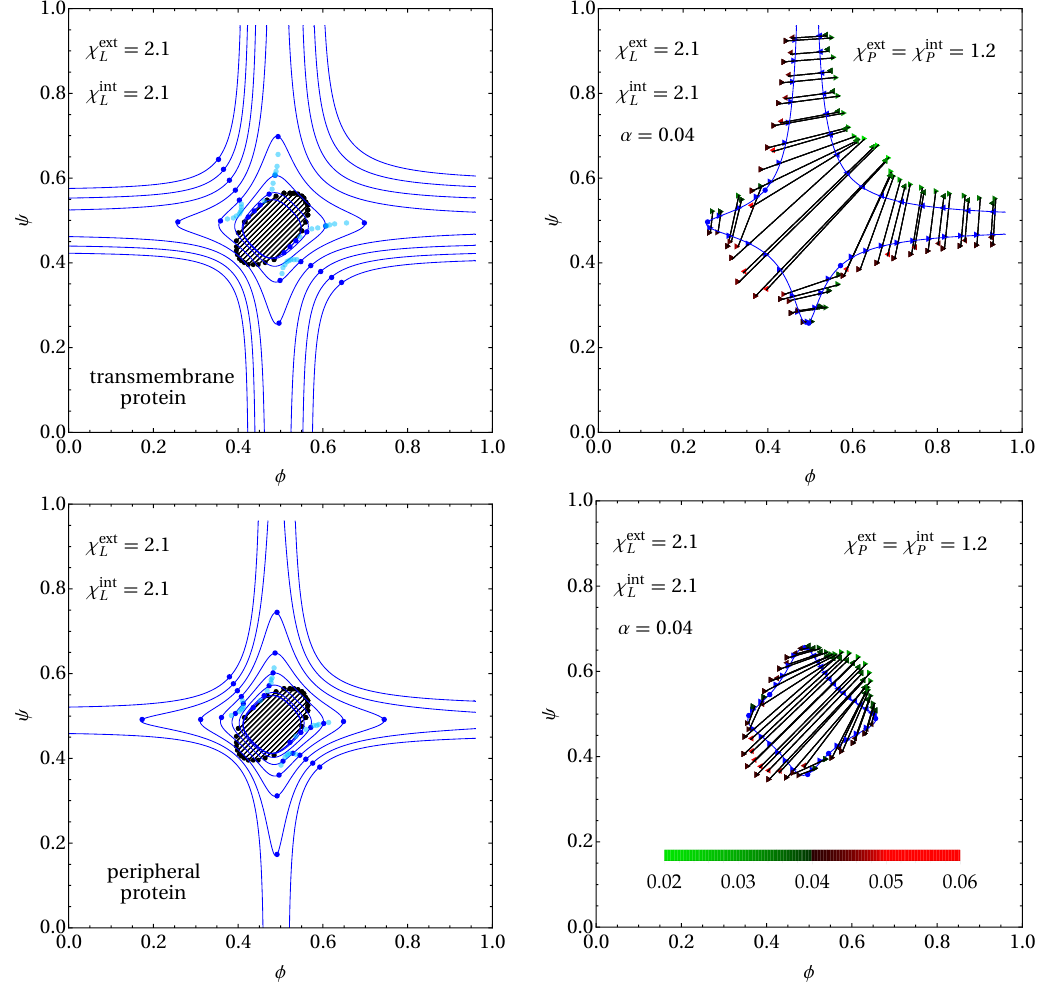
Figure 5. Sections of { φ , ψ , α } phase diagrams at α = 0.04 for transmembrane proteins (top diagrams) = χ int = 2.1 in both leaflets and Λ = 0.05. Left and peripheral proteins (bottom diagrams), with χ ext L L diagrams : Spinodal lines (solid lines in blue color) with the locations of the associated critical points (blue bullets), calculated for χ P = 0 (the innermost spinodal) and changing in increments of 0.3 until reaching χ P = 2.1 (the outermost spinodal). The light-blue bullets mark additional critical points at selected positions without the corresponding spinodal lines being displayed. The tie lines shown (black lines) correspond to the innermost spinodal. Because of χ P = 0 for that spinodal, all coexisting phases have a protein mole fraction of 0.04. We have thus marked the two ends of each tie line by black bullets. Right diagrams : Spinodal from the corresponding left diagram for χ P = 1.2 with a number of selected tie lines, calculated at positions on the spinodal marked by blue triangles. The α -value of the two coexisting phases (at the end of each tie line) are color-coded according to the legend in the bottom right